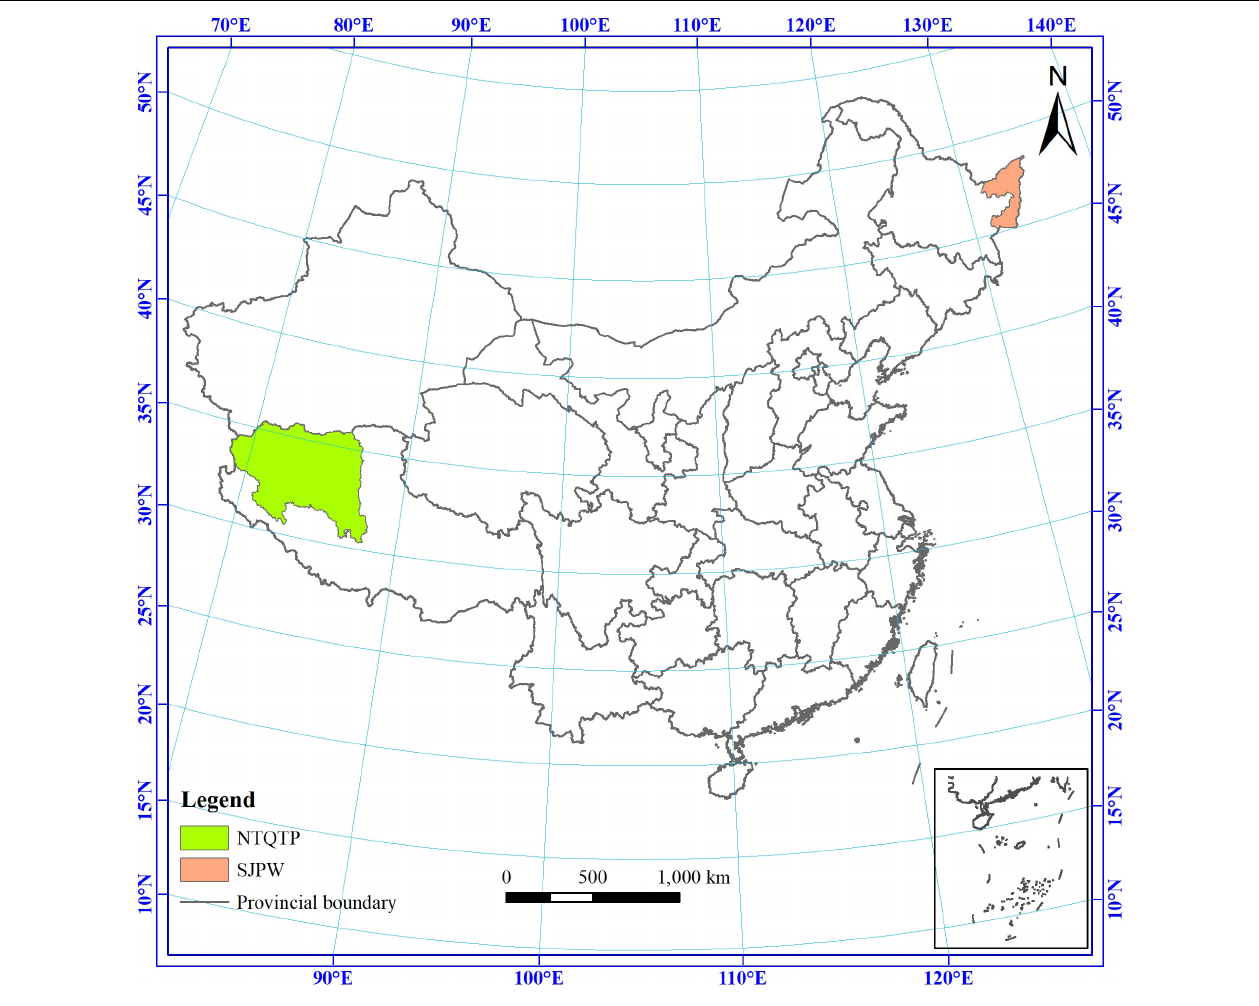
FIGURE 1 | Locations of study